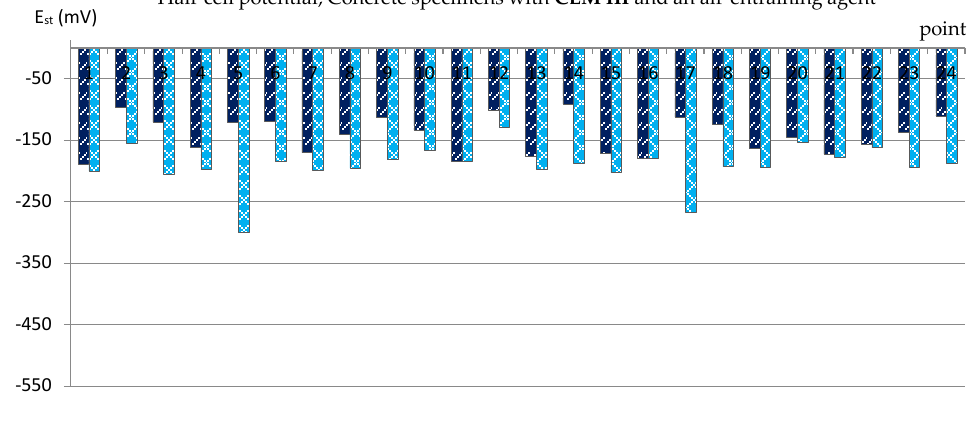
Even more clearly, the influence of the air-entraining agent could be observed in the specimens with blast-furnace slag cement. The values of the reinforcement half-cell potential obtained from the measurements performed after the cycles of freezing and thawing in specimens in which an air-entraining agent was used (C_III_a) in almost all measurement points did not exceed E st = − 200 mV (Figure 9), which allowed us to estimate the probability of corrosion of the reinforcement at the level of 5%. Only at two points did the half-cell potential of the reinforcement reach lower values: E st,5 = − 300 mV and E st,17 = − 267 mV, indicating a 50% probability of corrosion.